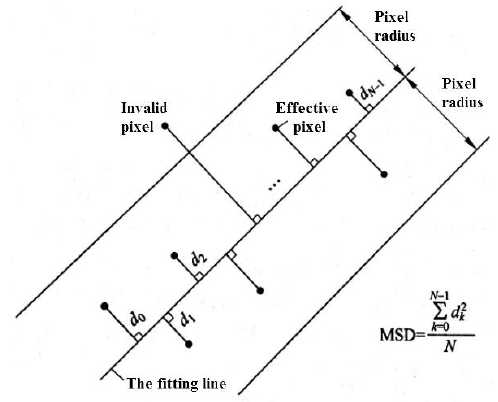
Figure 13. Schematic diagram of central line detection.